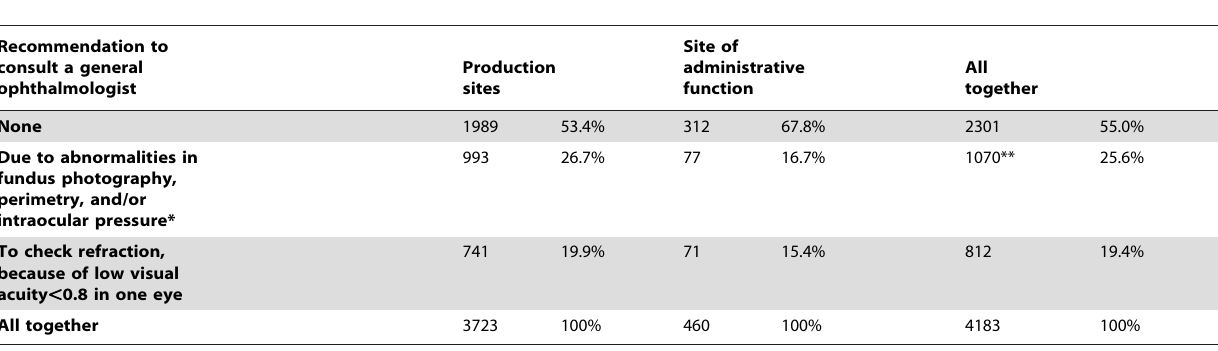
Table 9. Recommendation to consult a general ophthalmologist for all participants subdivided in production sites and sites of administrative function (n =4183).